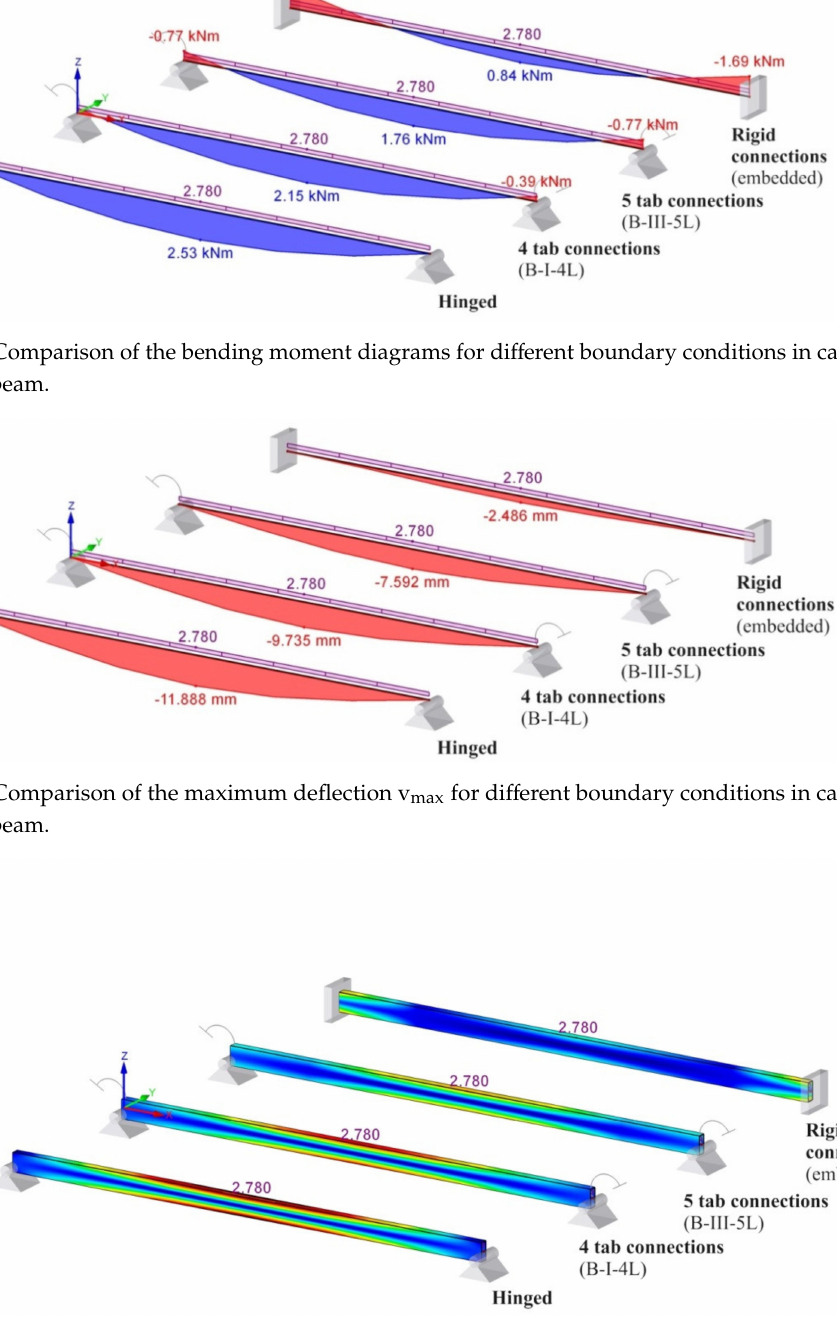
Figure 23. Comparison of the distribution of the equivalent stresses (von Mises) for di ff erent boundary conditions in case of the type B